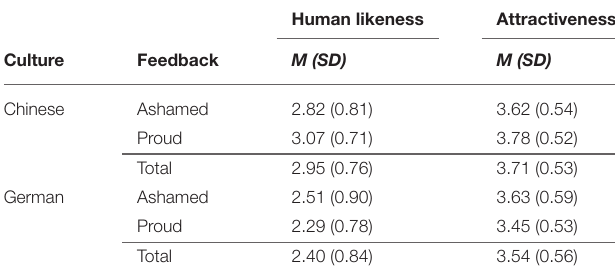
TABLE 3 | Descriptive statistics for self-report